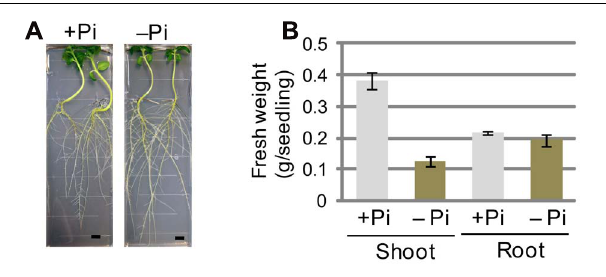
FIGURE 1 | Sesame plants grown under phosphate (Pi)-sufficient and Pi-depleted conditions. (A) Growth phenotypes of sesame seedlings grown on Pi-sufficient medium for 5 days and then on Pi-sufficient ( + Pi) or Pi-depleted ( − Pi) medium for 7 days. Bars represent 1 cm. (B) Fresh weights of shoots and roots of sesame plants grown on Pi-sufficient medium for 5 days and then on + Pi or − Pi medium for 14 days.Values shown for each of shoots ( n = 3) and roots ( n = 3) represent the mean ± SE for three independent measurements.